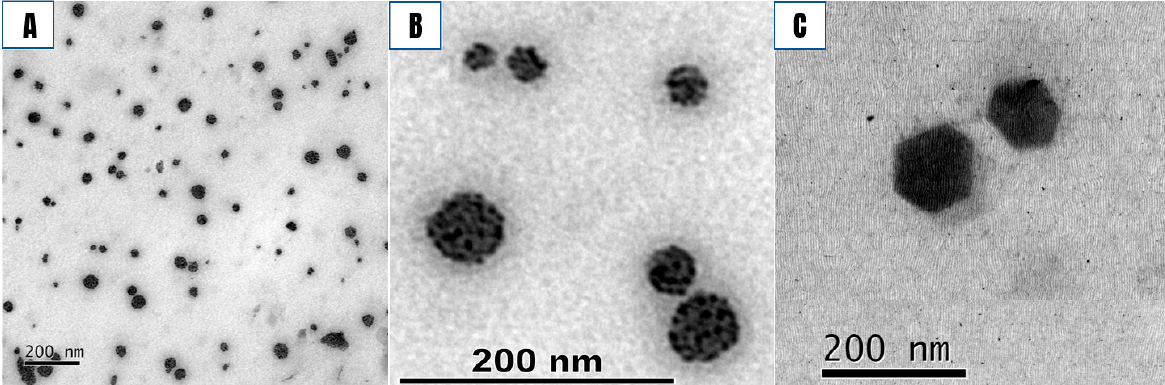
Figure 5. Transmission electron microscopy images of SLN-AlPc ( A , B ) and SLN ( C ). The micrographs show a spherical shape with small dark spots ( A , B ), suggesting the presence of AlPc. AlPc has a high affinity for osmium tetroxide, which explains the darker labeling. It is possible to observe that the SLN ( C ) presents a different morphology.